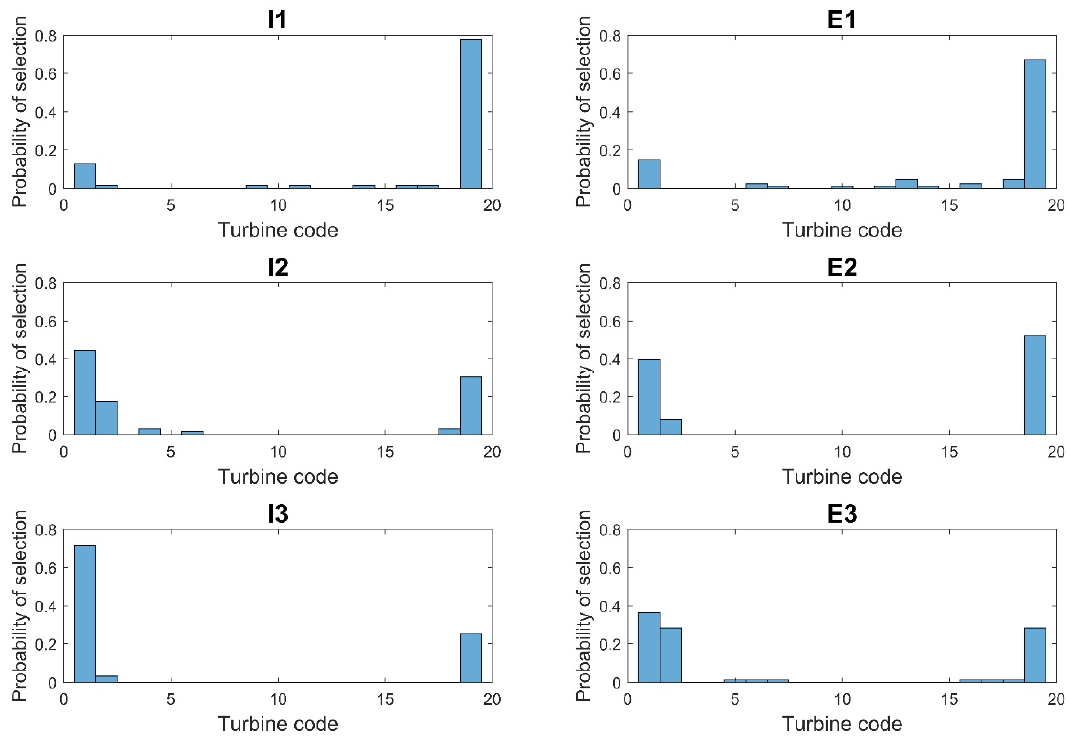
Figure 14. Probability of turbine selection for multiple turbines grid layouts.